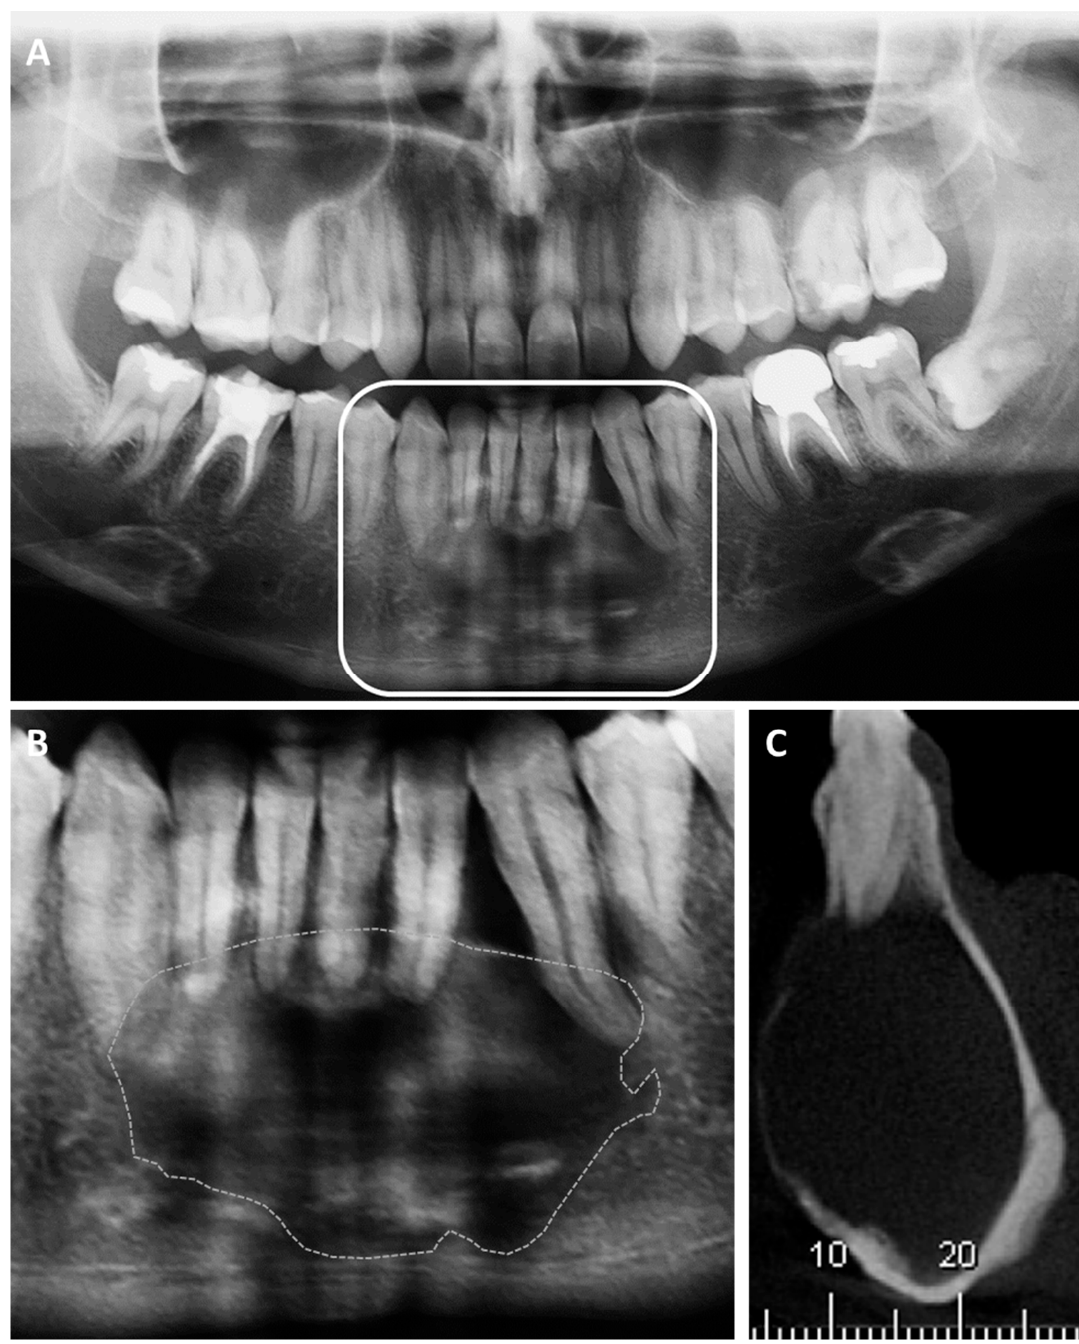
Figure 1. ( A , B )—Initial panoramic radiography, revealing a well-defined unilocular radiolucent lesion between inferior canines, reaching the mandibular base. The dashed line highlights the limits of the lesion. ( C )—Representative sagittal cut of the preoperative CT scan, confirming a significant radiolucent lesion involving the vestibular and lingual regions.